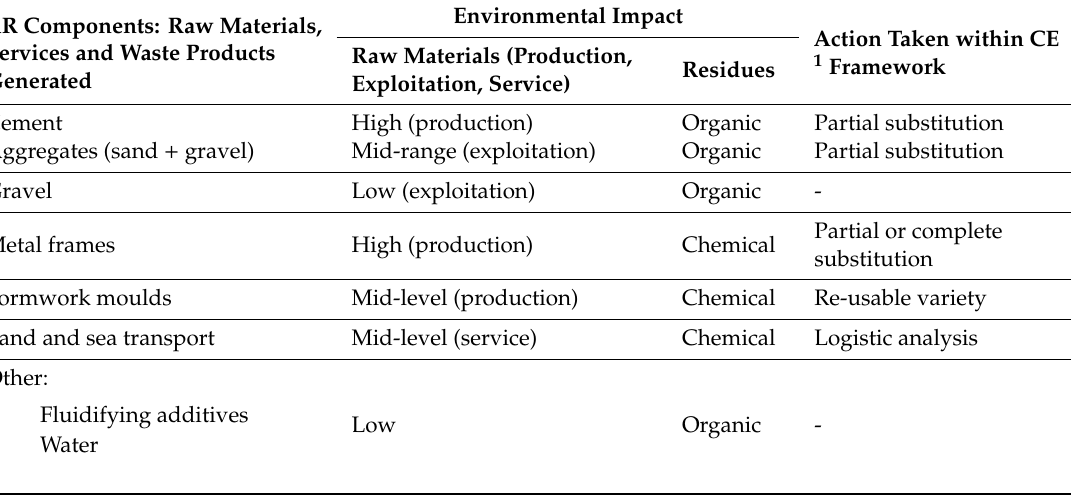
Table 3. CAR components as raw materials, services and chemical or organic